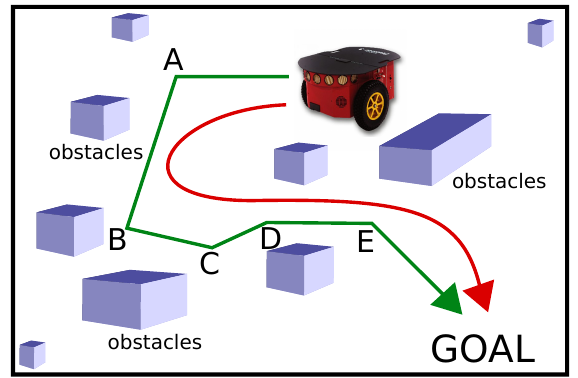
Figure 1. The green path is a path consisting of straight lines and sharp turns at points A,B,C,D, and E. A smooth and continuous path is shown in red